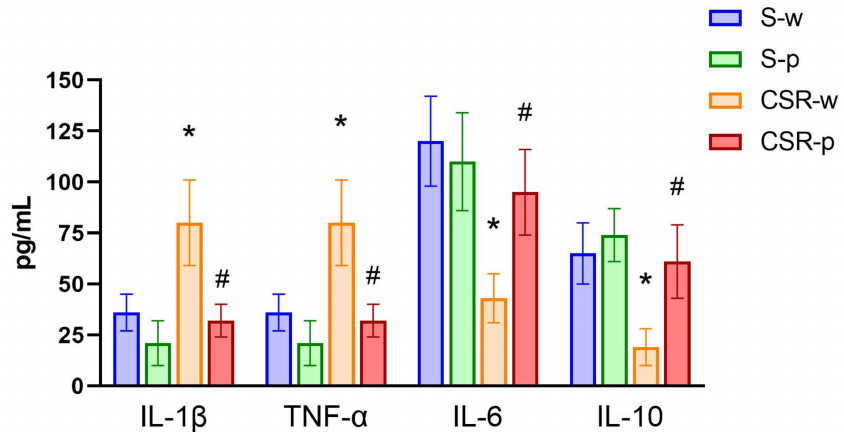
Figure 5. Effects of CSR and SLAB51 on systemic inflammation. Proinflammatory and anti- inflammatory cytokines levels in blood plasma of all groups of mice. Analytes concentrations are expressed as mean ± SEM. One-way ANOVA results were (F (3, 24) = 3.379; p = 0.03473) for IL-6, (F (3, 24) = 7.816; p = 0.00082) for IL-10, (F (3, 24) = 6.376; p = 0.00248) for TNF α , and (F (3, 24) = 9.891; p = 0.0002) for IL-1 β . * indicates statistical significance between S-w and CSR-w, while # indicates statistical significance between CSR-w and CSR-p.